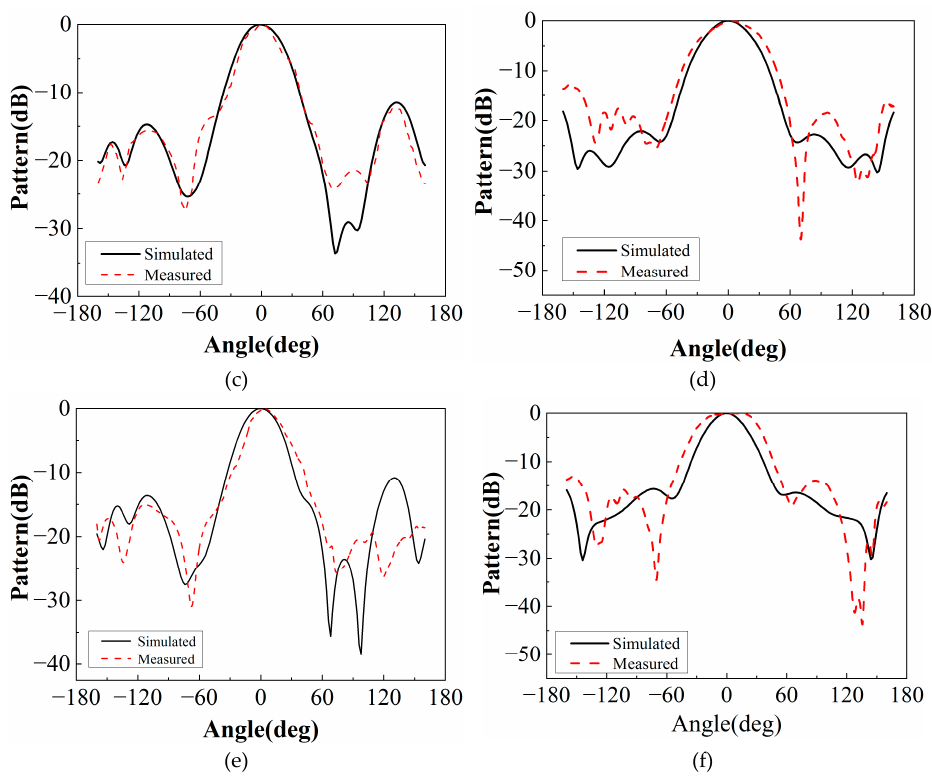
Figure 22. Radiation pattern of E and H surfaces of F-P antenna. ( a ) E-plane at 9.5 GHz; ( b ) 9.5 GHz H-plane . ( c ) E-plane at 10 GHz . ( d ) H-plane at 10 GHz . ( e ) E-plane at 10.5 GHz . ( f ) H-plane at 10.5 GHz.